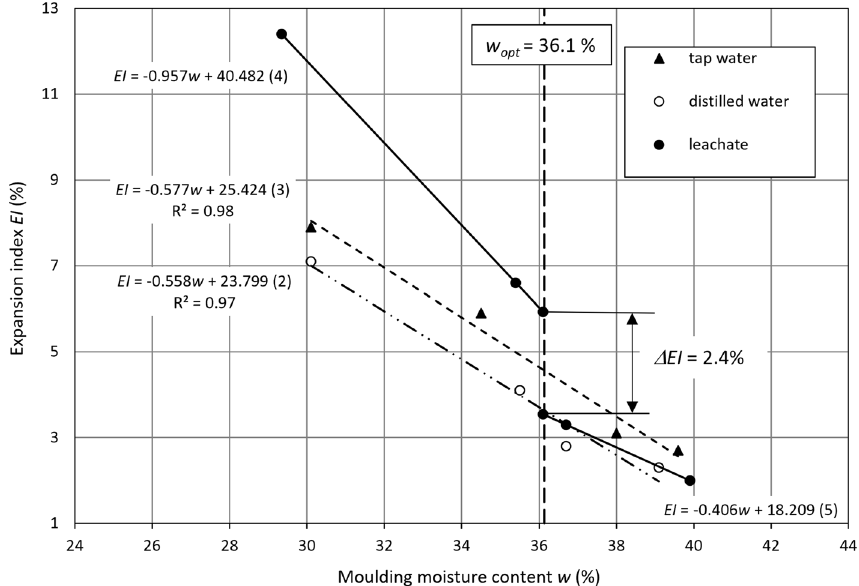
Figure 5. Correlation between the expansion index and moulding moisture content.